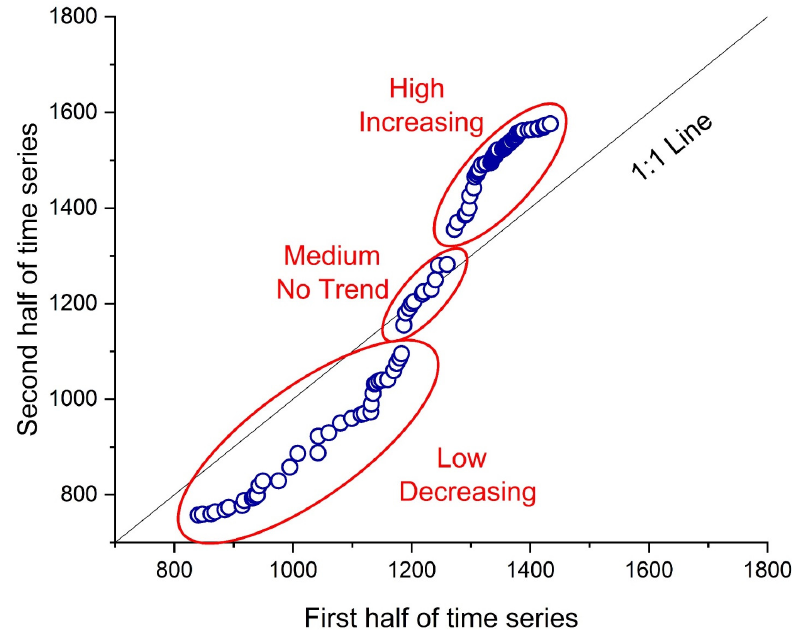
Figure 2. Illustration of the innovative trend analysis method.